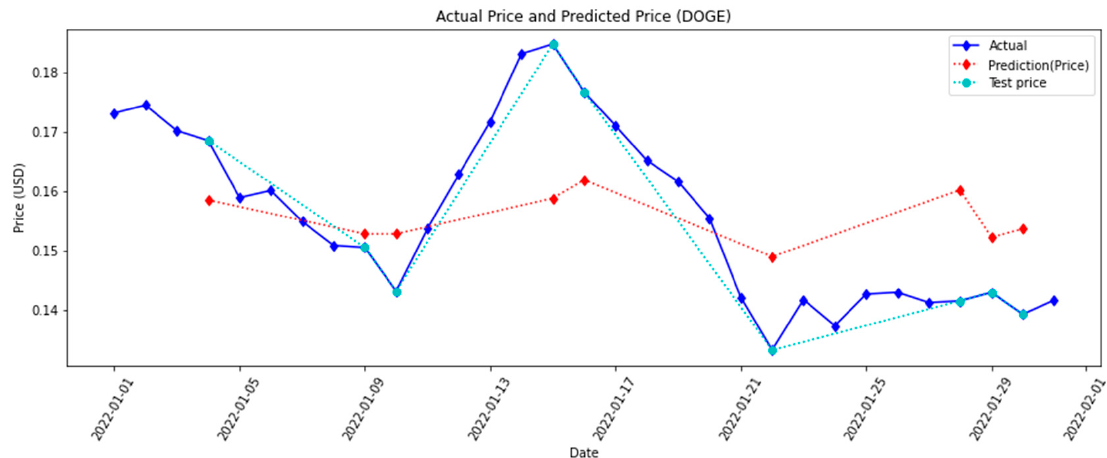
Figure 13. The plot of actual, test, and predicted trends in Dogecoin.